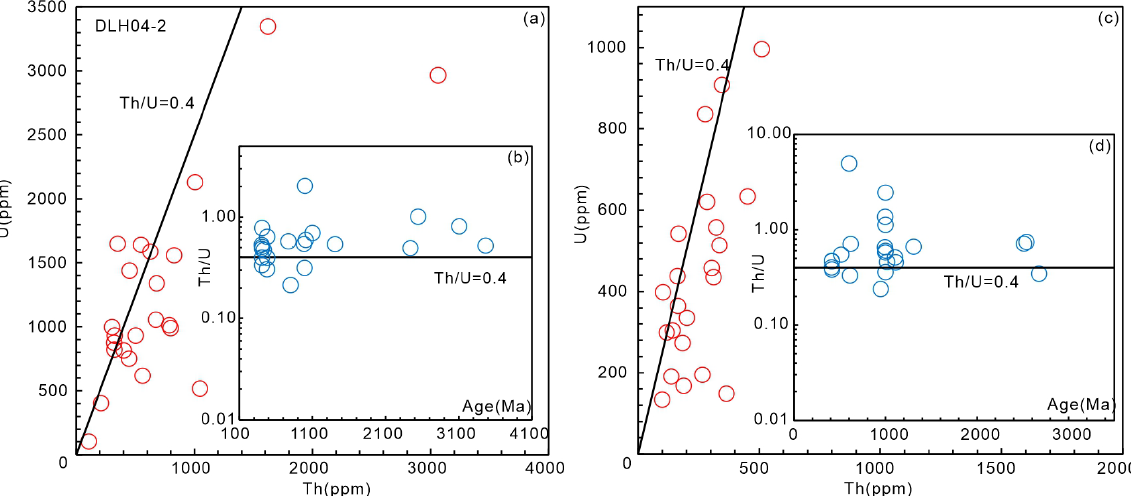
Figure 7. ( a ) Th vs. U content of zircon diagram of sample DLH04 - 2; ( b ) Age vs. Th/U of zircon diagram of sample DLH04 - 2; ( c ) Th vs. U content of zircon diagram of sample DLH04 - 7; ( d ) Age vs. Th/U of zircon diagram of sample DLH04 - 7 of the felsic volcanics in the Maoniushan Formation .